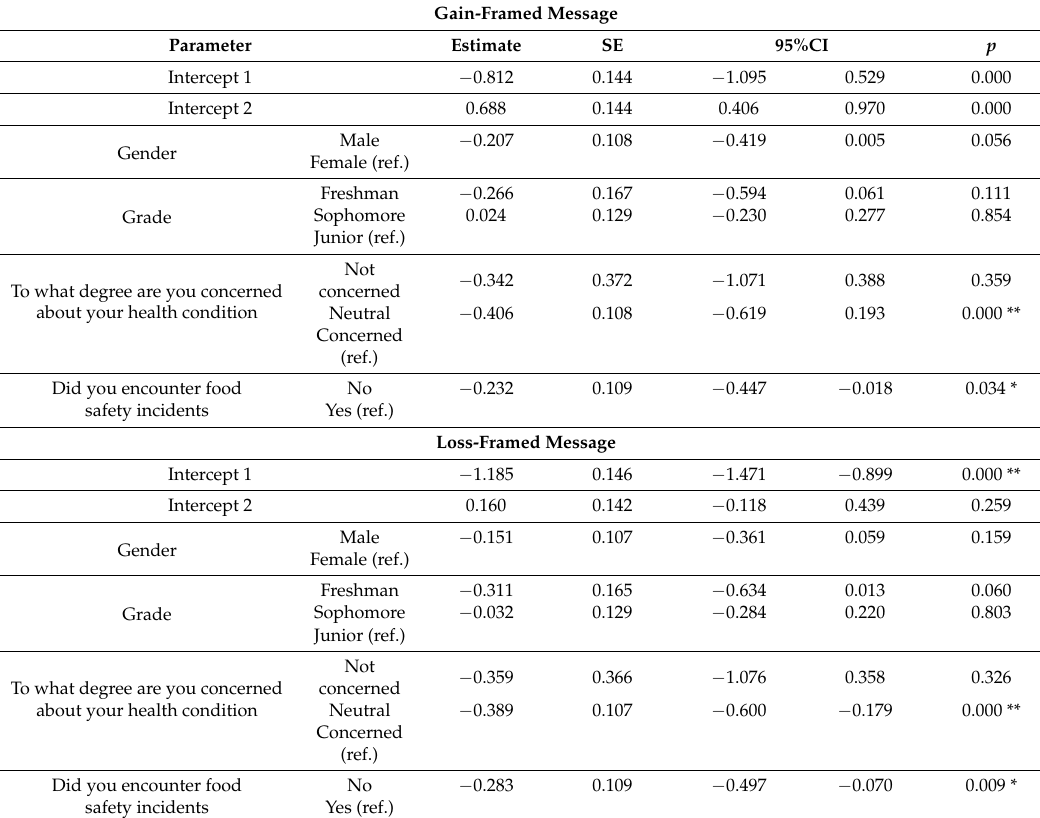
Table 6. Ordered Multivariate Logistic Regression for demographic characteristics and personal